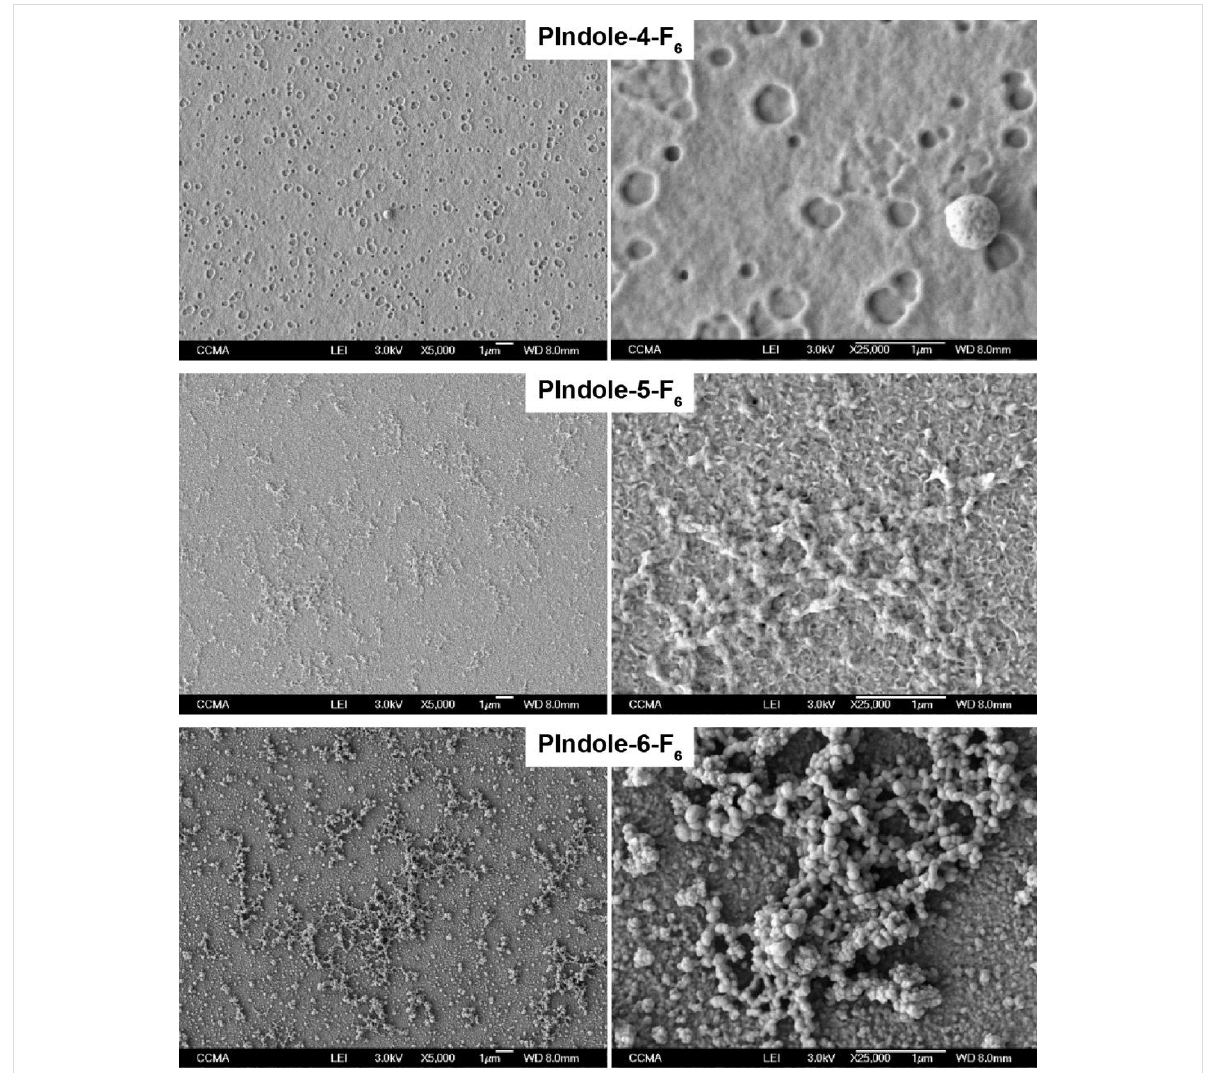
Figure 3: SEM images at two different magnifications (5000× and 25000×) of the polyindoles substituted with C 6 F 13 chains in the different positions.